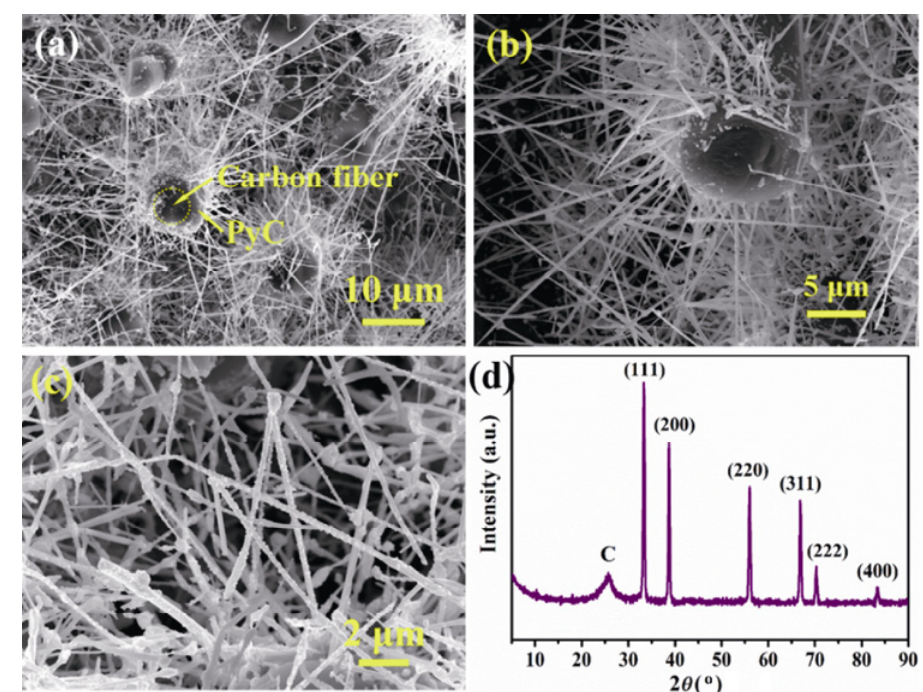
Fig. 2 Microstructures of HfC whiskers. (a–c) SEM images of HfC whiskers; (d) corresponding XRD pattern.